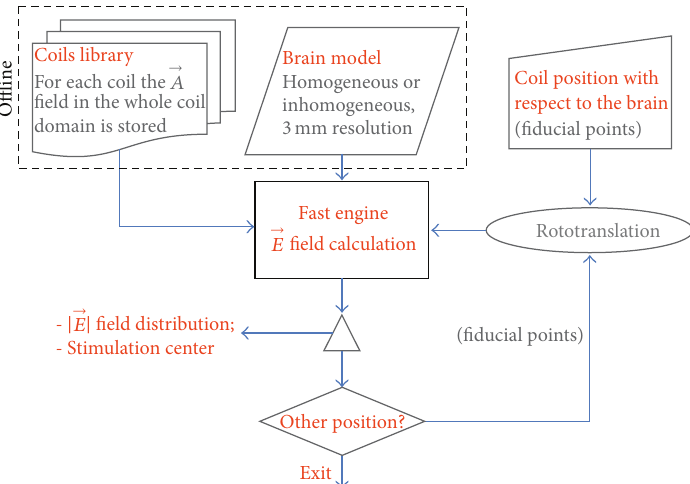
⃗𝐸 field calculation.